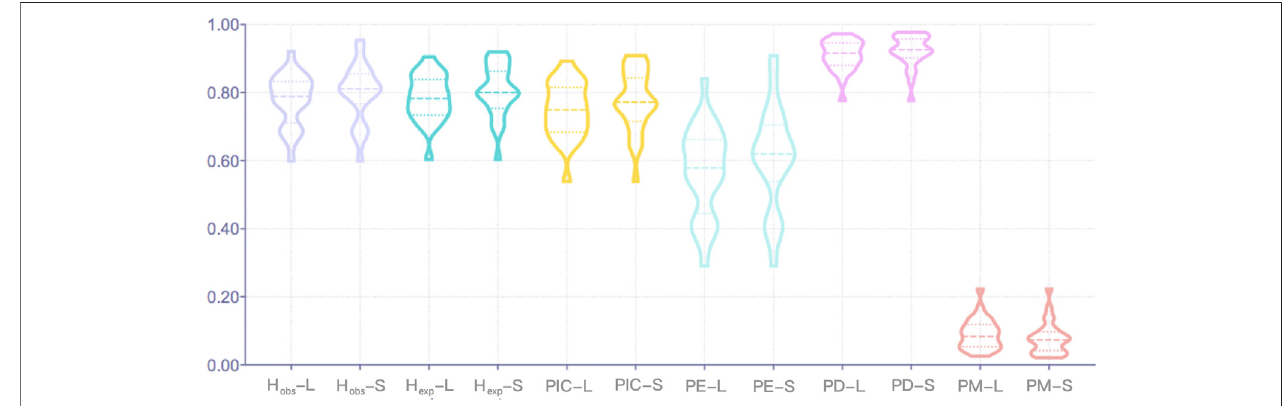
FIGURE 1 | The forensic parameters of 27 A-STR loci at the length (L)- and sequence (S)-based levels. A-STR, autosomal short tandem repeat.